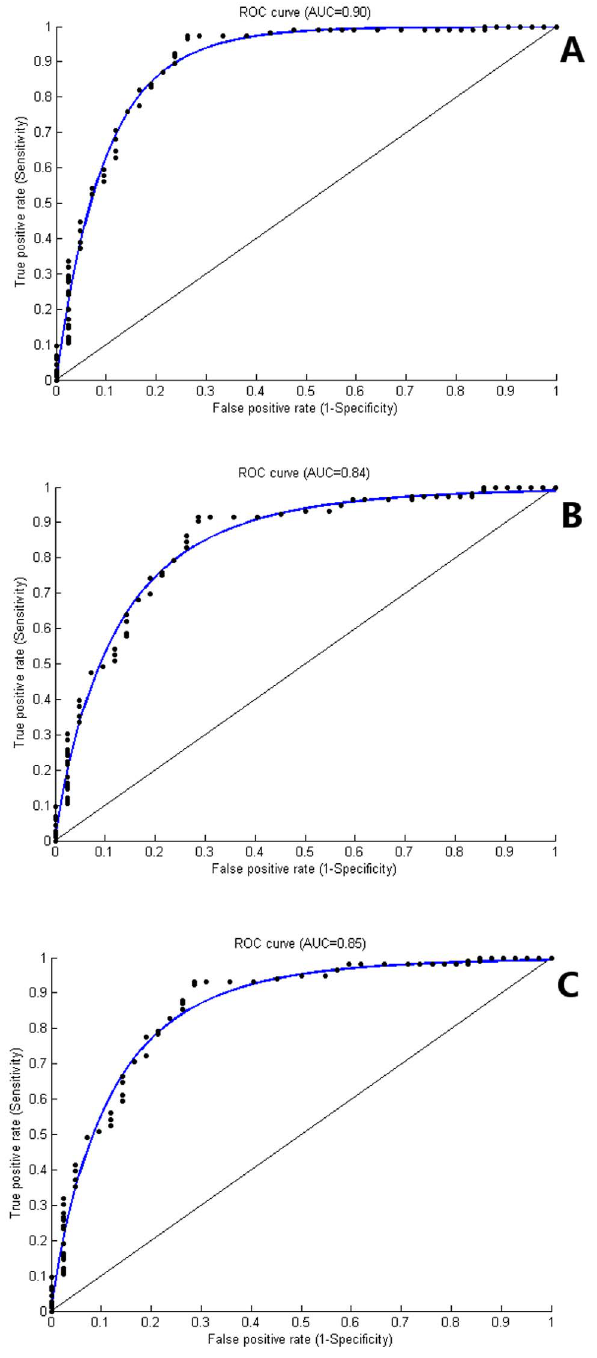
Figure 1. Mean Area Under Receiver Operating Characteristic (ROC) curve. Mean ROC (AUC) for Support Vector Machine algorithm with Linear Kernel for (A) Prediction of Symptom scale was 0.90. (B) Prediction of Global Health/QoL was 0.84. (C) Prediction of Functional scale was 0.85.